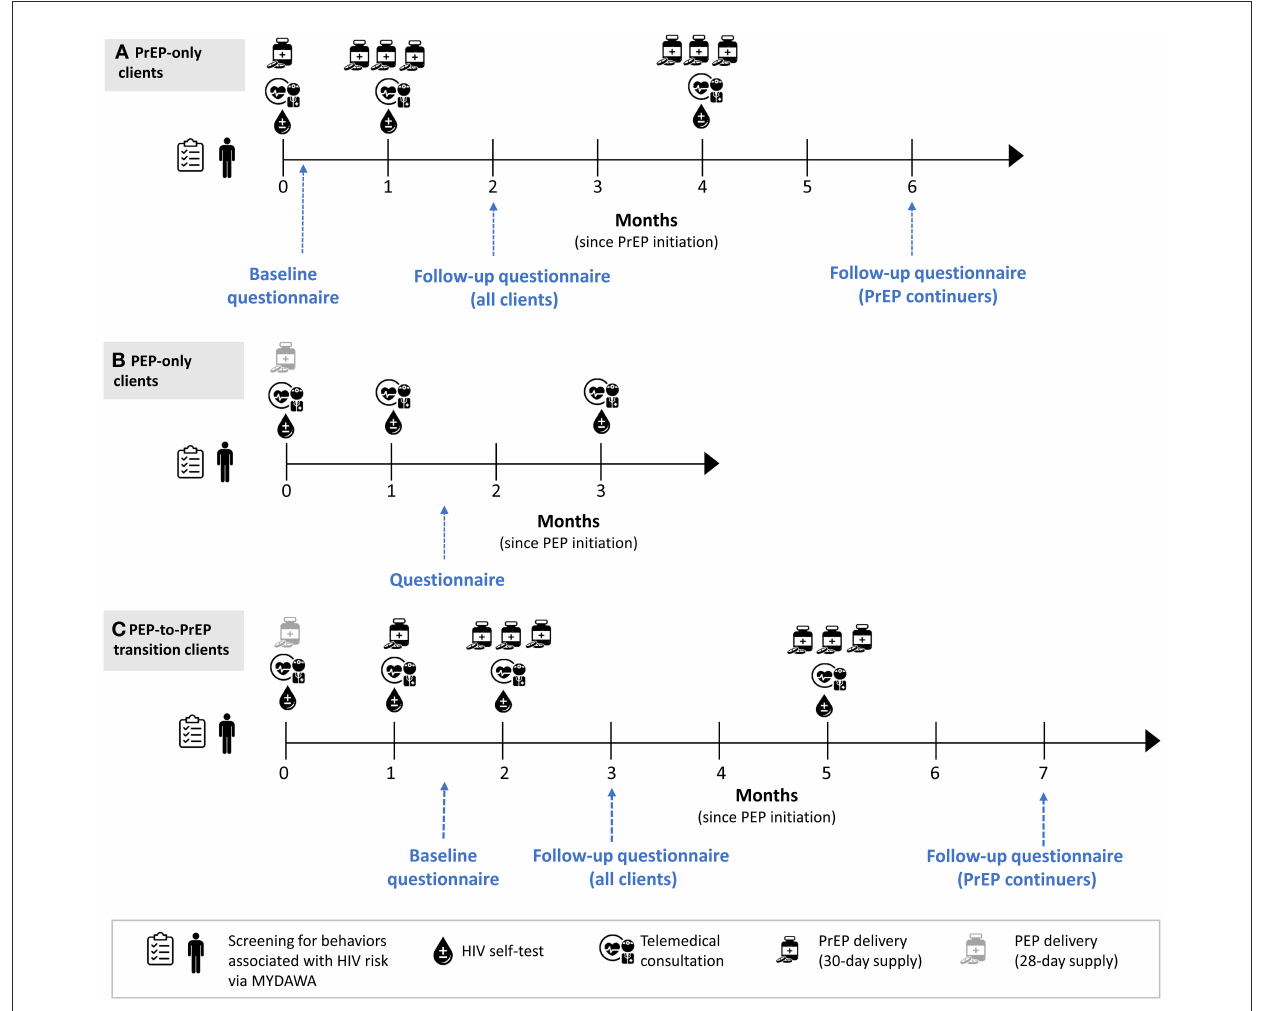
FIGURE2 Overview of quantitative data collection at the client level. (A) PrEP only clients. (B) PEP-only clients. (C) Clients who transitioned from PEP to